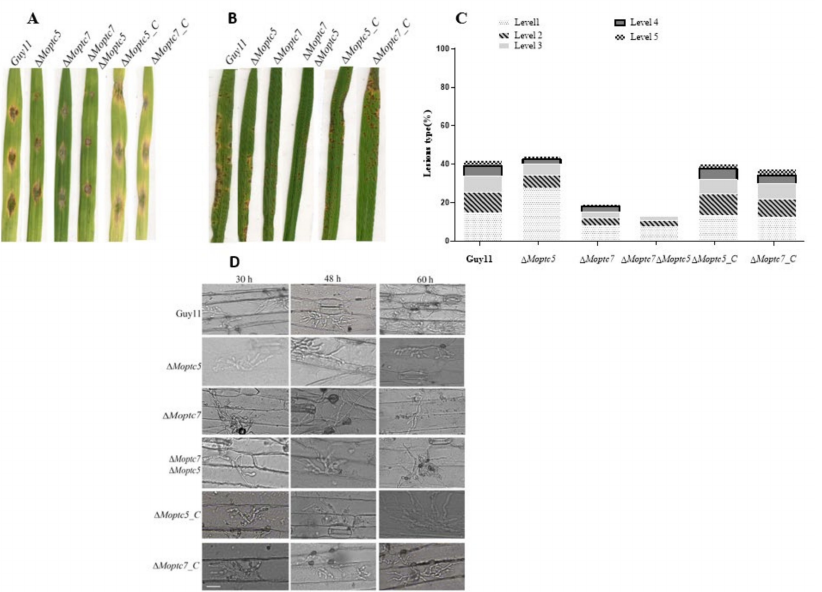
Figure 9. MoPtc5 and MoPtc7 play important roles in M. oryzae virulence. ( A ) Pathogenicity assay for Guy11, ∆ Moptc5 , ∆ Moptc7 and ∆ Moptc7 ∆ Moptc5 on barley leaves using drops of conidia suspension. ( B ) The pathogenicity of ∆ Moptc5 , ∆ Moptc7 and ∆ Moptc7 ∆ Moptc5 mutants in comparison to Guy11 using conidia sprays on 3 weeks old barley leaves. ( C ) Extents of lesions development as blast symptoms caused by the indicated strains, Level 1 (uniform dark brown pinpoint lesions without visible centers), Level 2 (small lesions with distinct centers surrounded by a dark brown margin, 1 mm in diameter), Level 3 (small eyespot lesions approximately 2 mm in length with tan centers surrounded by dark brown margins), Level 4 (intermediate size eyespot lesions, approximately 3–4 mm in length), Level 5 (large eyespot lesions approximately 5 mm in length). ( D ) Cuticle penetration defects of the mutants.